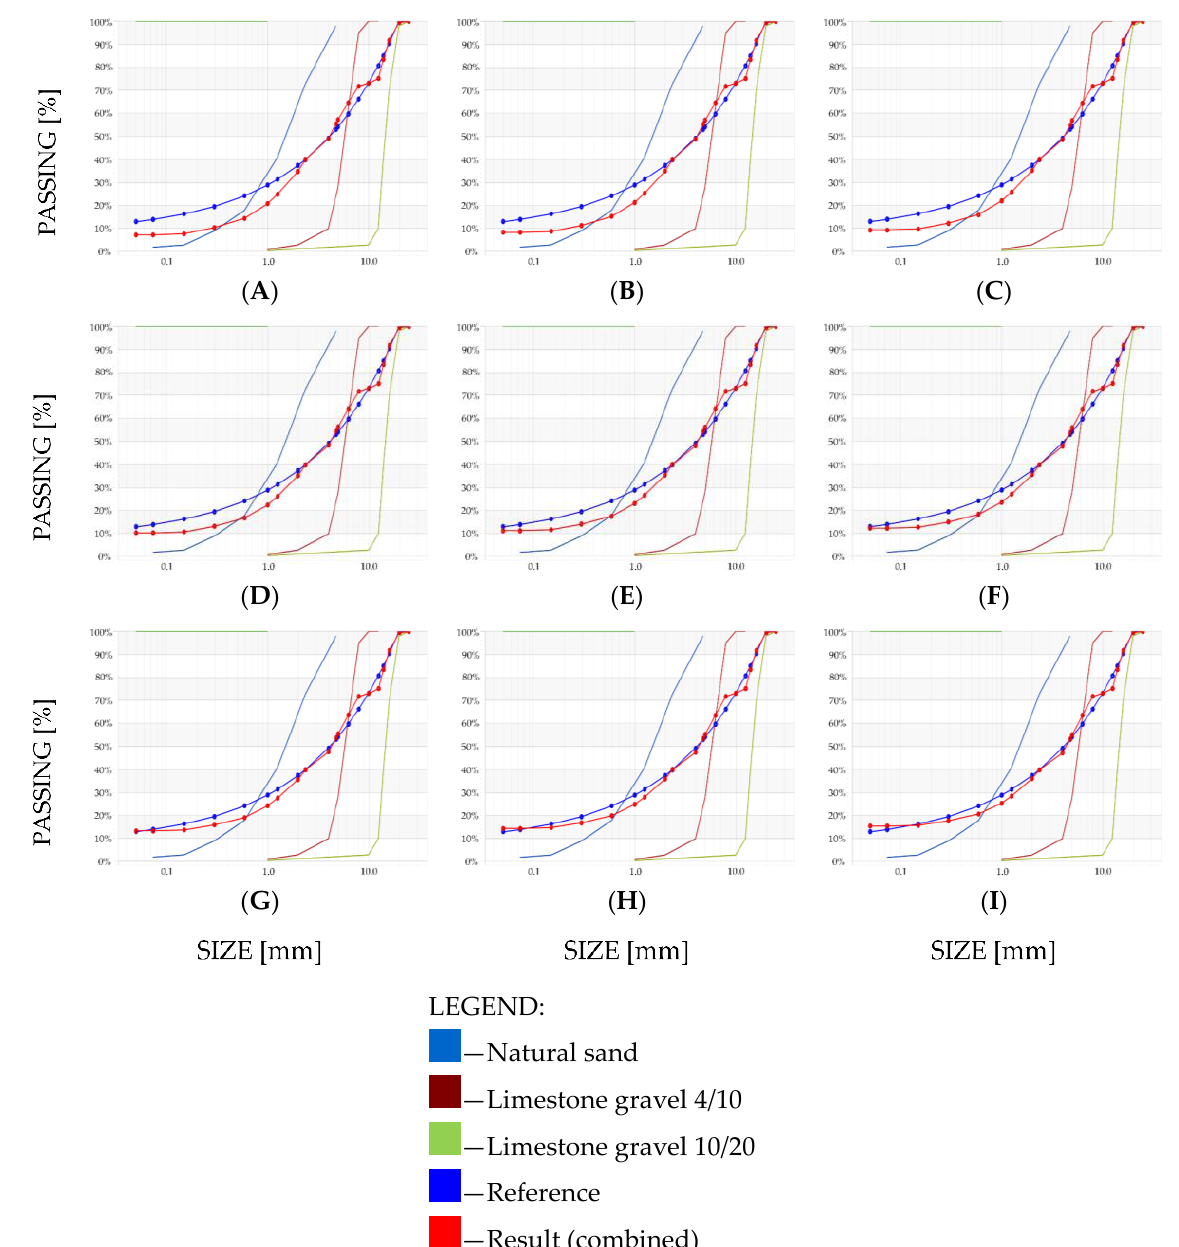
Figure A5. Gradings and fitting curves for Recipe #3—standard mix with superplasticizer (polycarboxylate ether), retarder (phosphate) and air entrainer (tensides) designed according to the Bolomey Method: ( A ) 10 MPa; ( B ) 15 MPa; ( C ) 20 MPa;